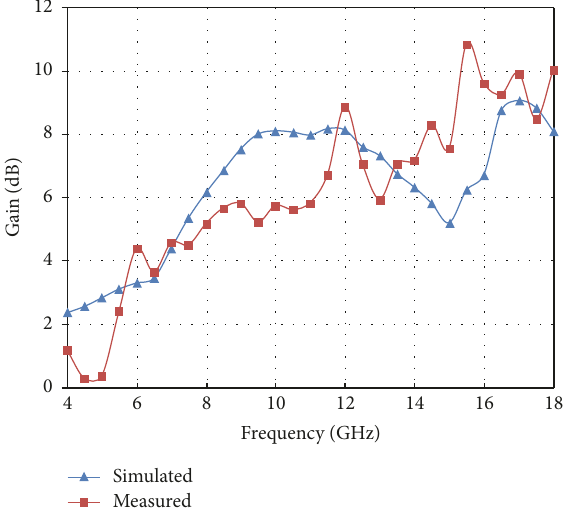
Figure 8: The simulated and measured gain of the proposed